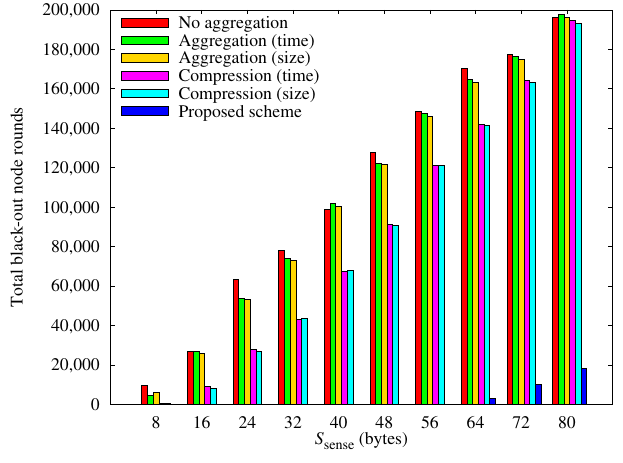
Figure 6. Number of cumulative black-out nodes.